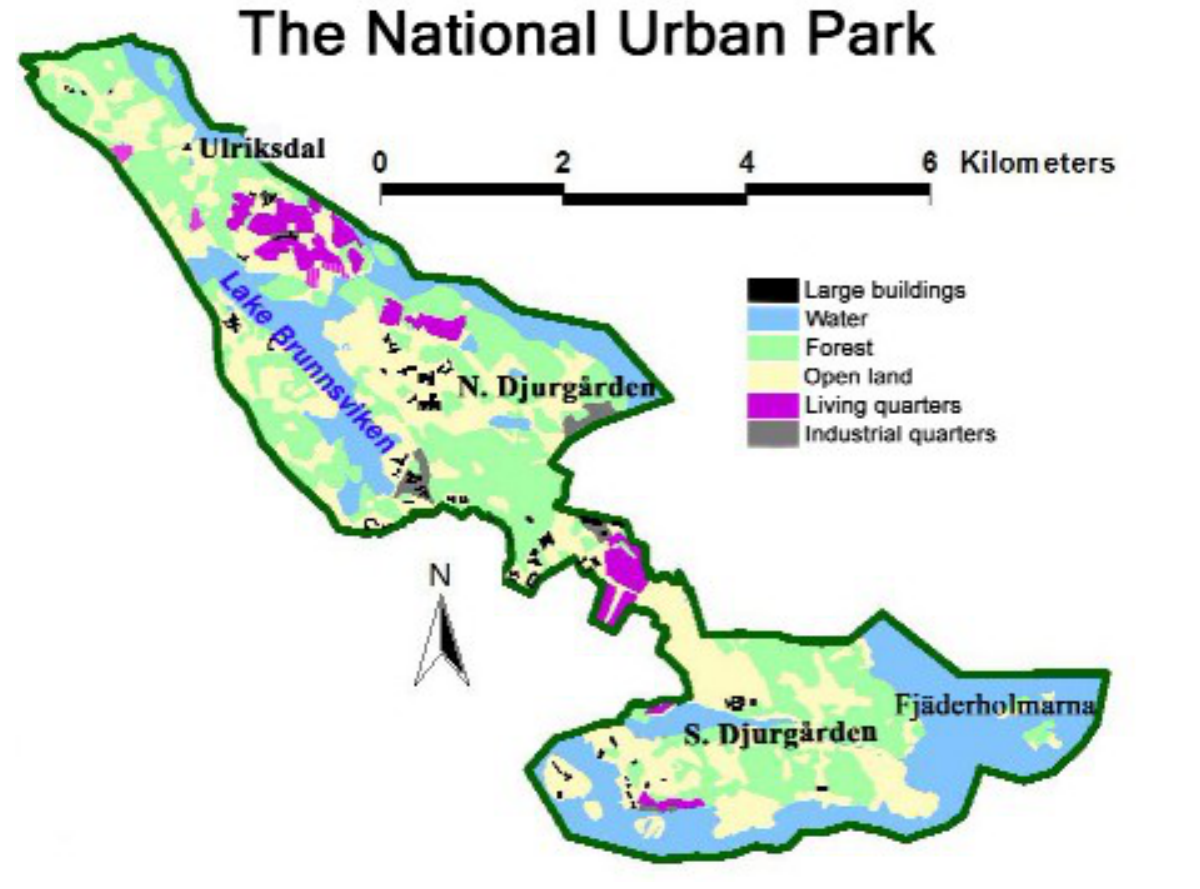
Fig. 2 . The National Urban